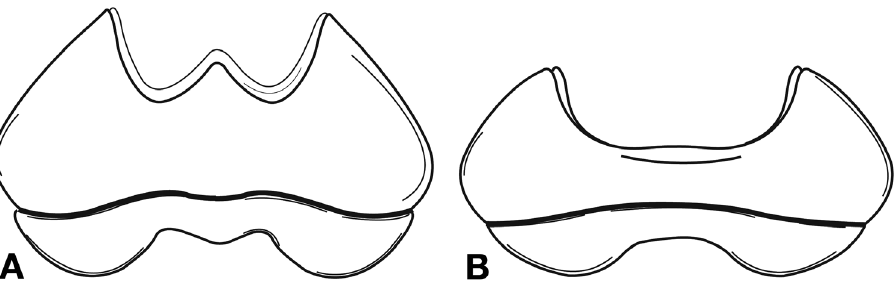
Figure 8. Line drawing and comparison of menta of A Amphimenes beichatiensis sp. n. (with tooth) B Brachichila hypocrita Chaudoir (without